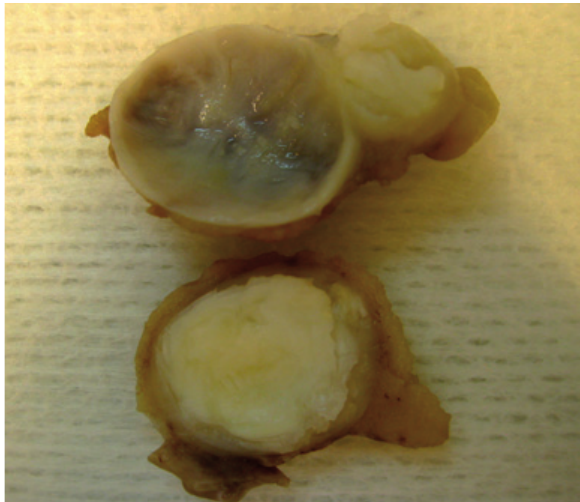
Figure 3 - Photograph of the sectioned surgical specimen shows a bilobulated mass with a fibrous capsule that was composed of a laminated white-yellow paste like material, typical of